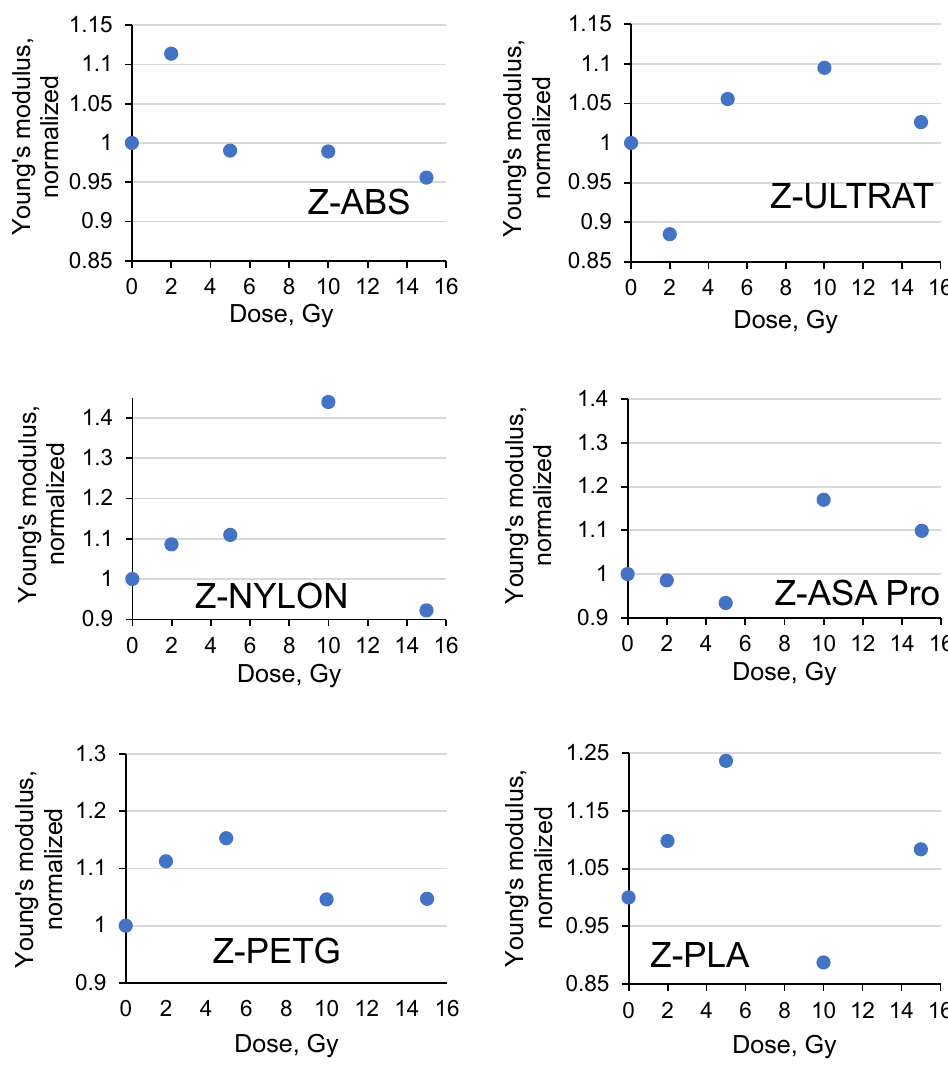
Figure 6. Variations of Young’s modulus of irradiated 3D printed fi laments.